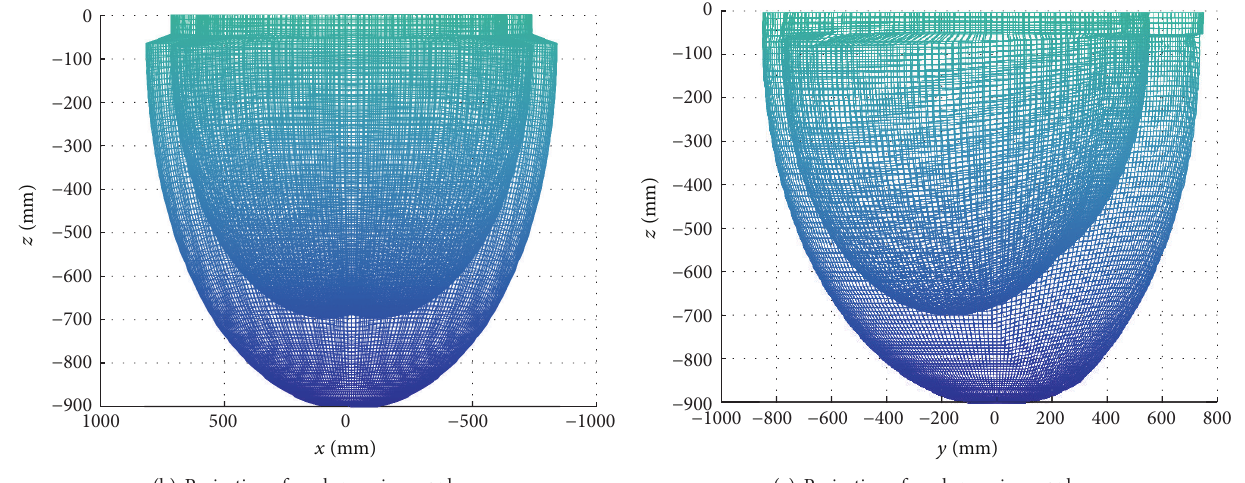
Figure 5: The reachable workspace of 2-UPS+UP